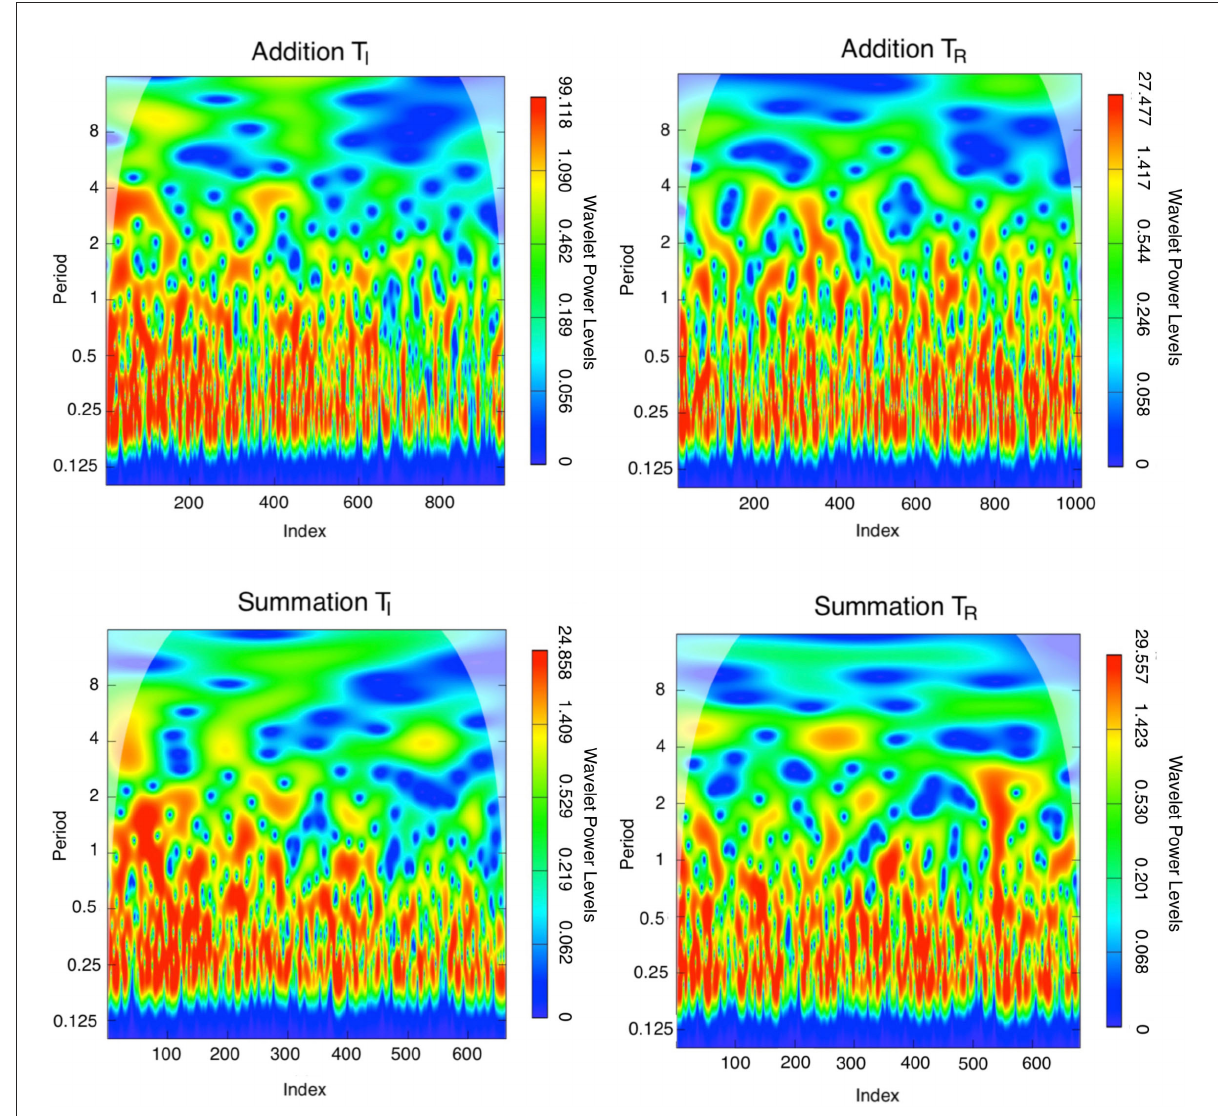
FIGURE5 Morlet continuous wavelet transform for the addition and summation tasks for the initial study and return study periods, which highlights the wavelet spectra in each series. The colors code for wavelet power values from dark blue (low values), to red (high values). The low contrast zone in the image periphery indicates the cone of influence that delimits the region not influenced by edge effects. The wavelet power spectrum depicts the evolution of a time series’ variance at various frequencies, with periods of high variance corresponding to periods of high power at various scales. Whereas the highest wavelet power is distributed irregularly throughout the T R series, wavelet power is highest at index < 200 for the T I series especially for the addition task. These findings quantify the accelerated response time in the earlier part of the T I series and the more consistent response time in the T R series with interspersed volatility. sstd= skewed student-t